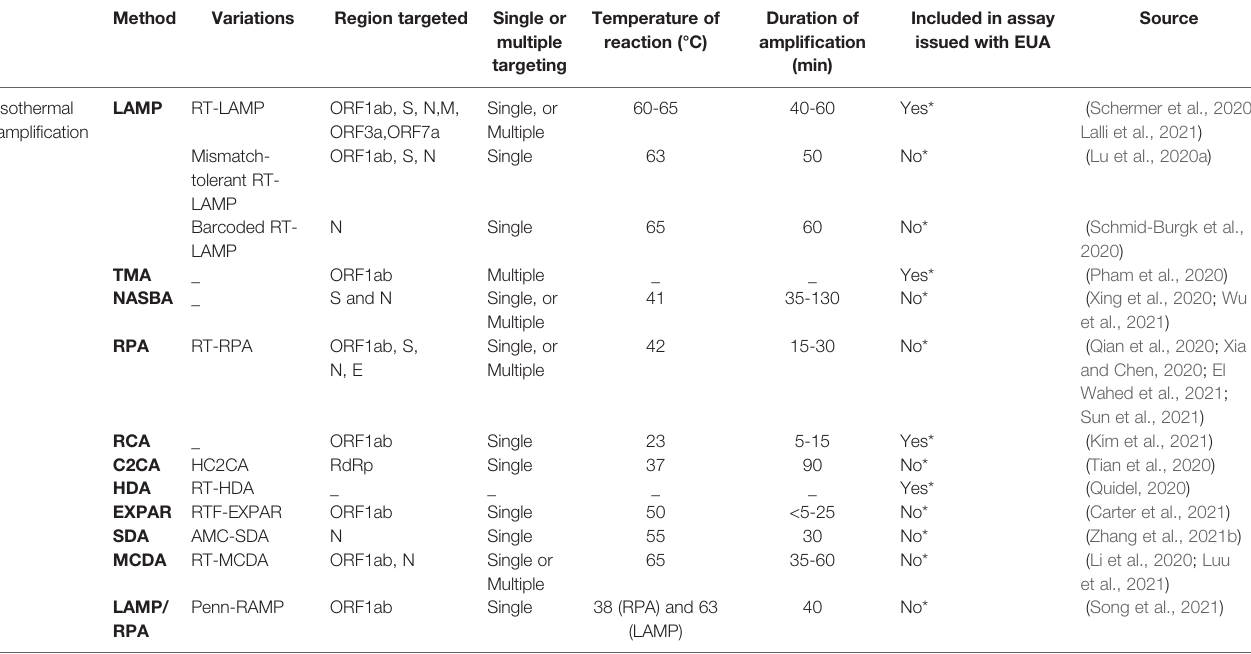
TABLE 4 | Compilation of strategies of isothermal ampli fi cation explored for SARS-CoV-2 diagnostic.